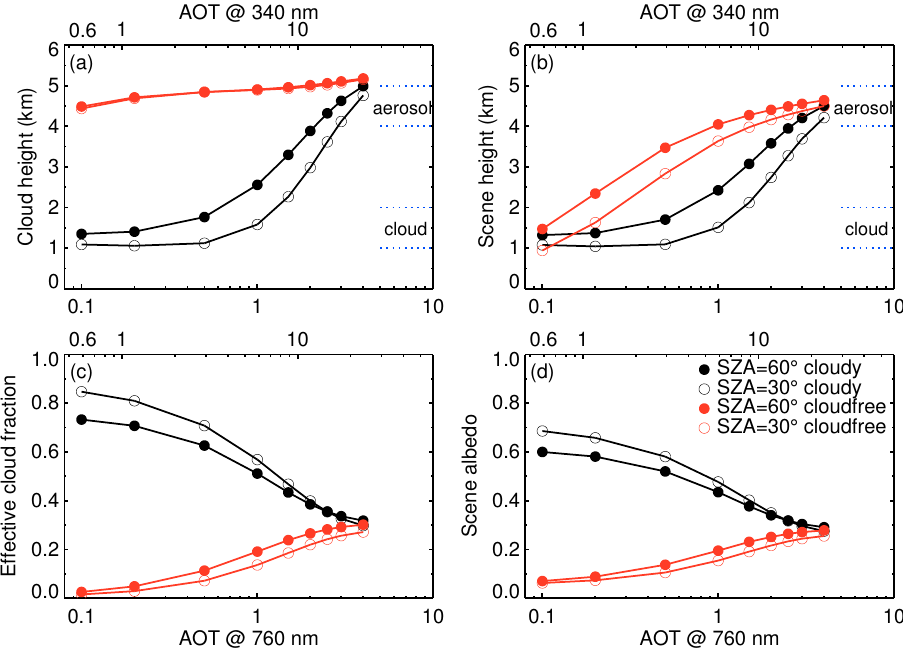
Fig. 1. FRESCO retrieval results of (a) cloud height, (b) scene height, (c) effective cloud fraction, and (d) scene albedo using simulated O 2 A band spectra for biomass burning aerosol Case 1 in a cloud free scene and in a cloudy scene (COT=20). Aerosol optical thickness (AOT) is 0–4. The cloud layer is located between 1 and 2km altitude and the location of the aerosol layer is between 4 and 5km. The location of aerosol and cloud layers is indicated with dashed lines. Surface albedo is 0.05. Results for two solar zenith angles are plotted, 60 ◦ and 30 ◦ . Viewing direction is nadir. The y-axes, “cloud height” and “effective cloud fraction”, represent “aerosol height” and “effective aerosol fraction” for cloud free